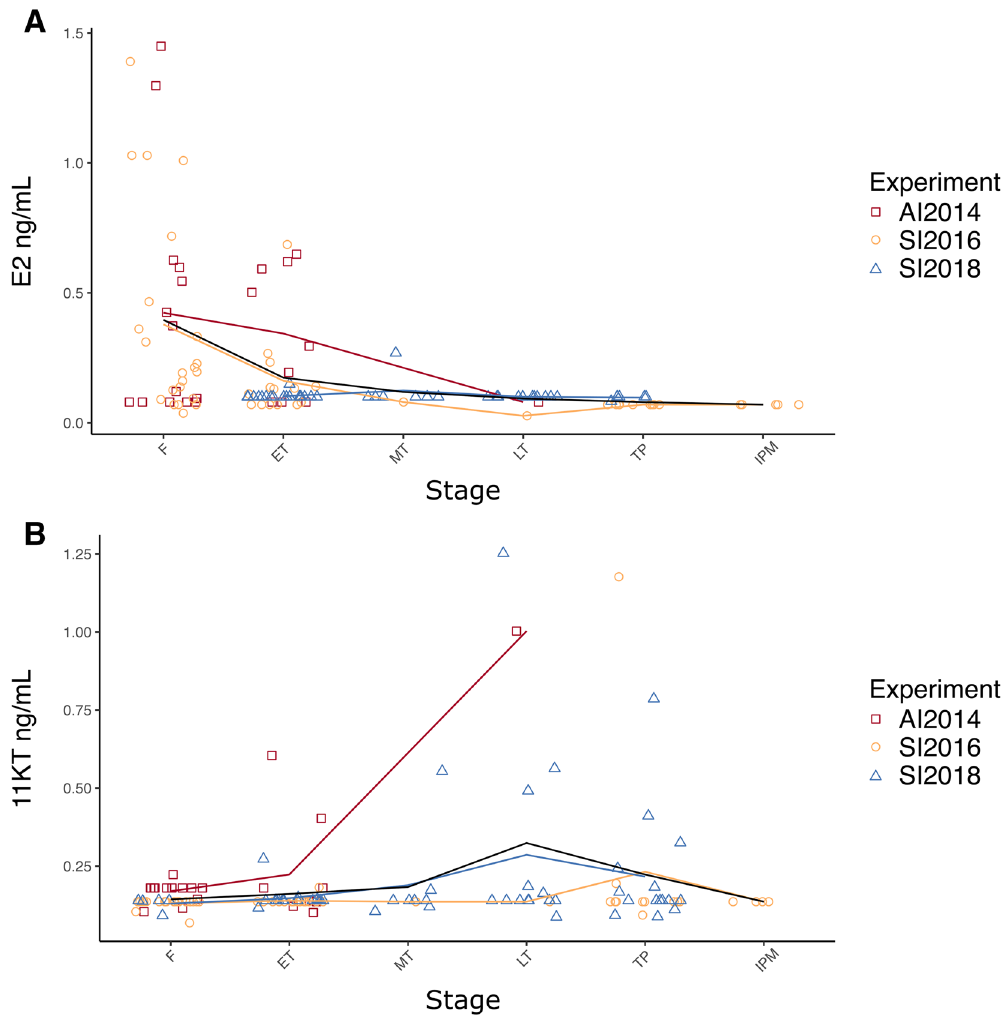
Figure 5. Plasma E2 ( A ) and 11KT ( B ) concentrations in females, early, mid- and late transitioning fish, and TP and IP males obtained across the three experiments, AI2014, SI2016 and SI2018. Each red (AI2014), yellow (SI2016) and blue (SI2018) line represents the variation in mean E2 or 11KT concentrations across groups per experiment while the black line represents the variation in overall mean concentrations for the three experiments altogether. Sample sizes: E2, F n = 36, ET n = 42, MT n = 8, LT n = 14, TP ↑ n = 17, IP n = 5; 11KT, F n = 40, ET n = 41, MT n = 9, LT n = 15, TP ↑ n = 26, IP n = 4. 11KT 11-ketestosterone, AI2014 aromatase inhibition experiment 2014, F initial phase female, E2 17β-estradiol, ET early transitioning fish, IPM initial phase male, LT late transitioning fish, MT mid-transitioning fish, SI2016 social induction experiment 2016, SI2018 social induction experiment 2018, TP terminal phase male. ↑ Both control males used throughout the experiments to create a socially inhibitory environment (SI2016: E2 n = 10, 11KT n = 10; SI2018: E2 n = 0, 11KT n = 10), and males obtained through sex change of manipulated females (SI2016: E2 n = 1, 11KT n = 1; SI2018: E2 n = 5, 11KT n = 5) were grouped altogether as TP males for the purpose of this